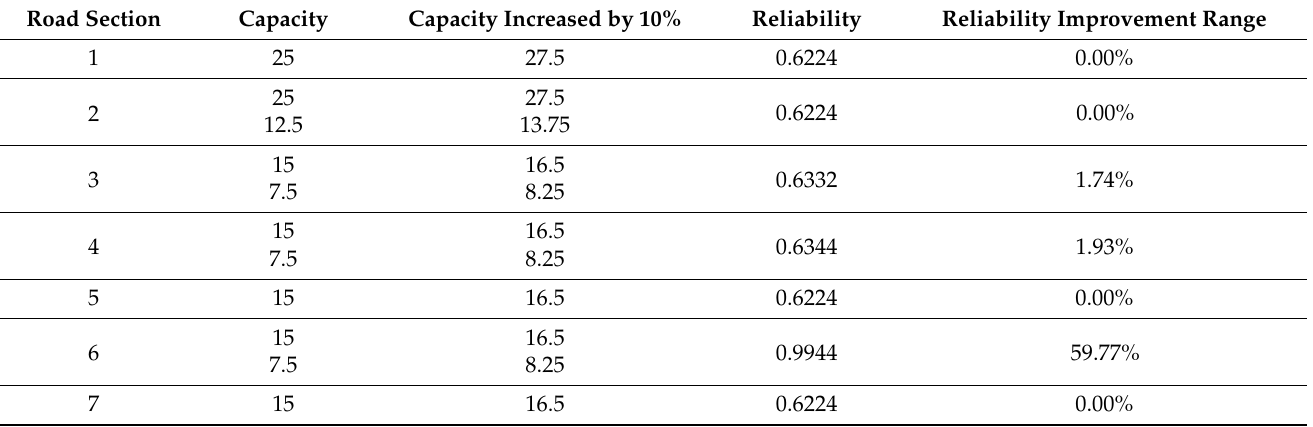
Table 7. Analysis table of contribution degree of road network reliability improvement.